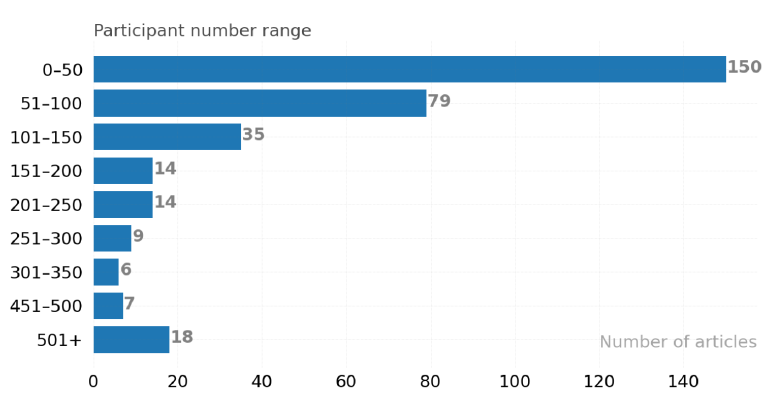
Figure 6. Distribution of the number of participants.